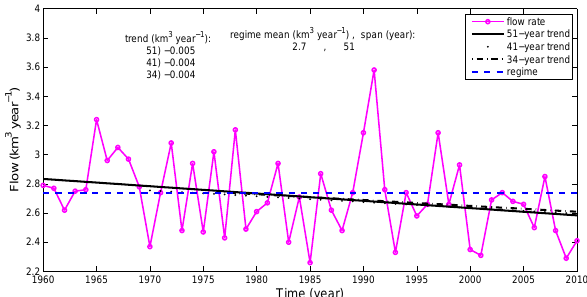
Fig. 3. Trends detected for three different analysis periods, 34, 41 and 51yr in duration, at Jasper. A significant trend of − 0.005km 3 yr − 1 with p value = 0.03 is detected for the period of